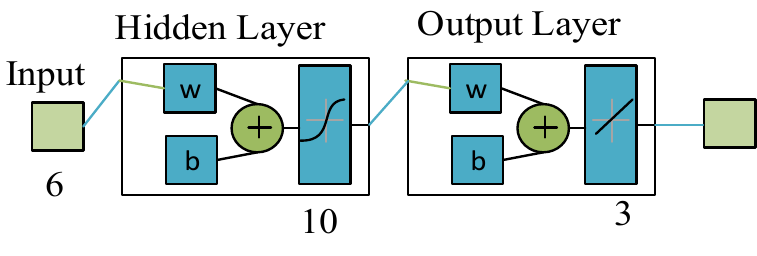
Figure 9. Shunt ANN Model.